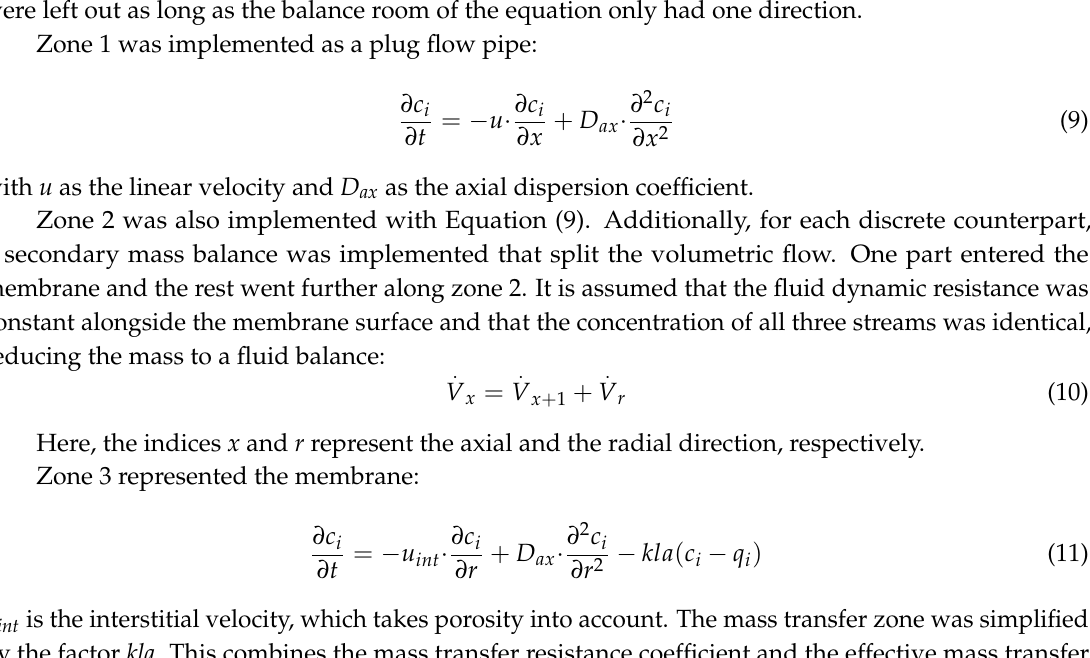
Figure 6. Fluid dynamic distribution in a membrane chromatography module.